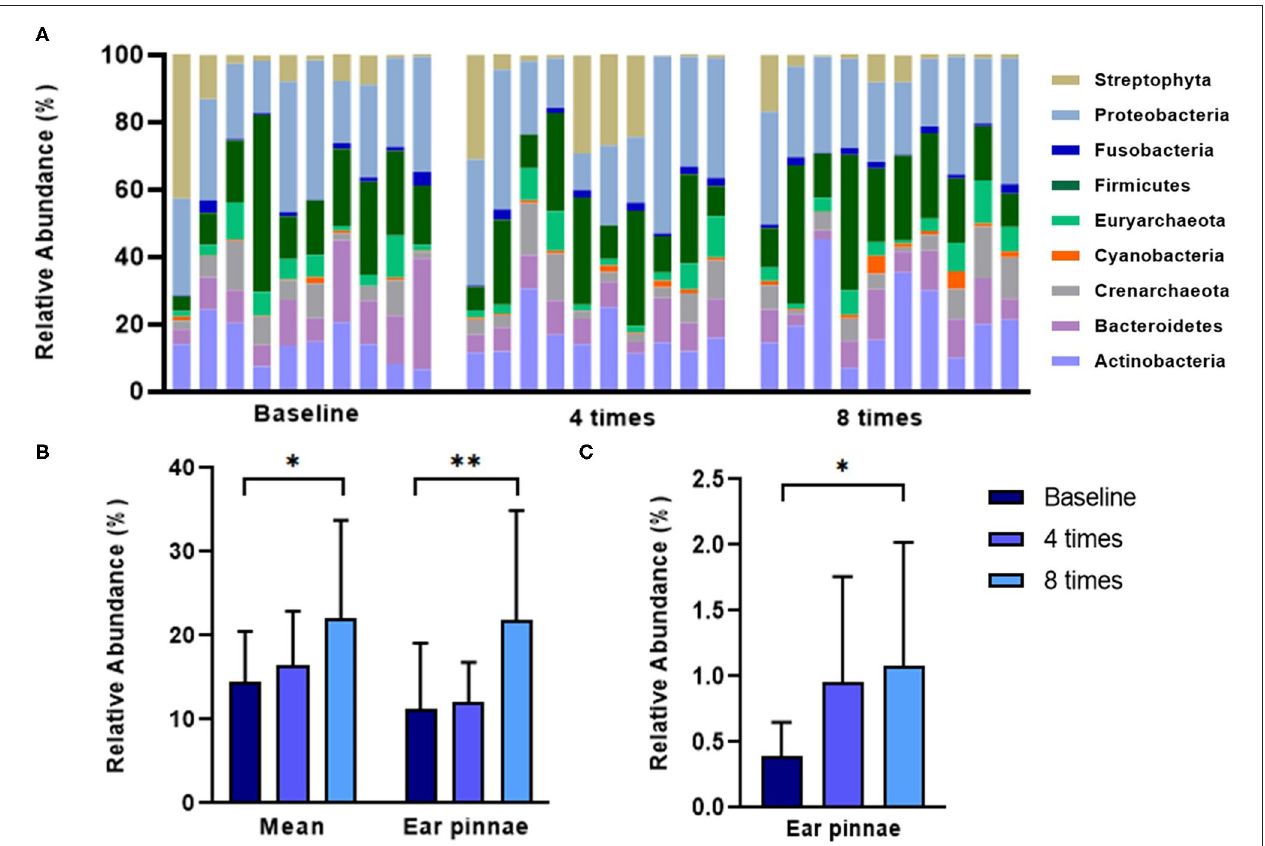
FIGURE 7 | Change in the skin microbiome in course of excimer light therapy in allergic group at the phylum level. (A) Individual composition of bacterial phyla in the course of excimer light therapy in the allergic group. (B) Statistical analysis of the relative abundance of the phylum Actinobacteria. (C) Statistical analysis of the relative abundance of the phylum Cyanobacteria. Four times, fourth session of excimer light therapy in allergic group; eight times, end of the excimer light therapy in allergic group; baseline, before the start of excimer light therapy in the allergic group. All values are expressed as mean ± standard error. * P < 0.05, ** P <